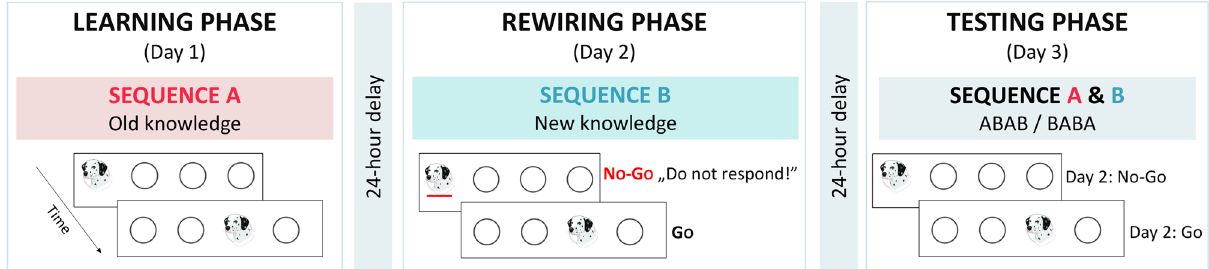
Figure 1. Design of the experiment. The experiment consisted of three phases, each separated by 24-h delays. During the Learning phase, participants extensively practiced a four-choice visuomotor reaction time task over 3600 trials, divided into three periods. In this task, a stimulus appeared in one of four horizontally arranged circles on the screen, and participants were asked to respond as quickly and accurately as they could using a response box. The associations of Sequence A (referred to as old knowledge) were acquired in this phase. Then during the Rewiring phase, a structural change was introduced to the task with Sequence B to prompt the rewiring of the old knowledge by acquiring the associations of this new sequence (referred to as new knowledge). Additionally, to engage participants’ inhibitory control processes in this phase, they were asked to suppress their responses on some trials (stimuli underlined with a red line during the task, No-go trials), but could respond on other (Go) trials. This phase also consisted of 3600 trials, divided into three periods. In the Testing phase, using a shorter version of the task, knowledge of both sequences was probed in a counterbalanced order (ABAB or BABA on the figure, where A and B refer to the sequence used in the Learning and Rewiring phases, respectively). Here, responses were allowed on all trials, including previously suppressed No-go trials, to assess the effect of inhibitory control on rewiring. The stimulus was taken from the public domain (retrieved on 26/09/2017 from: www. pixab ay.